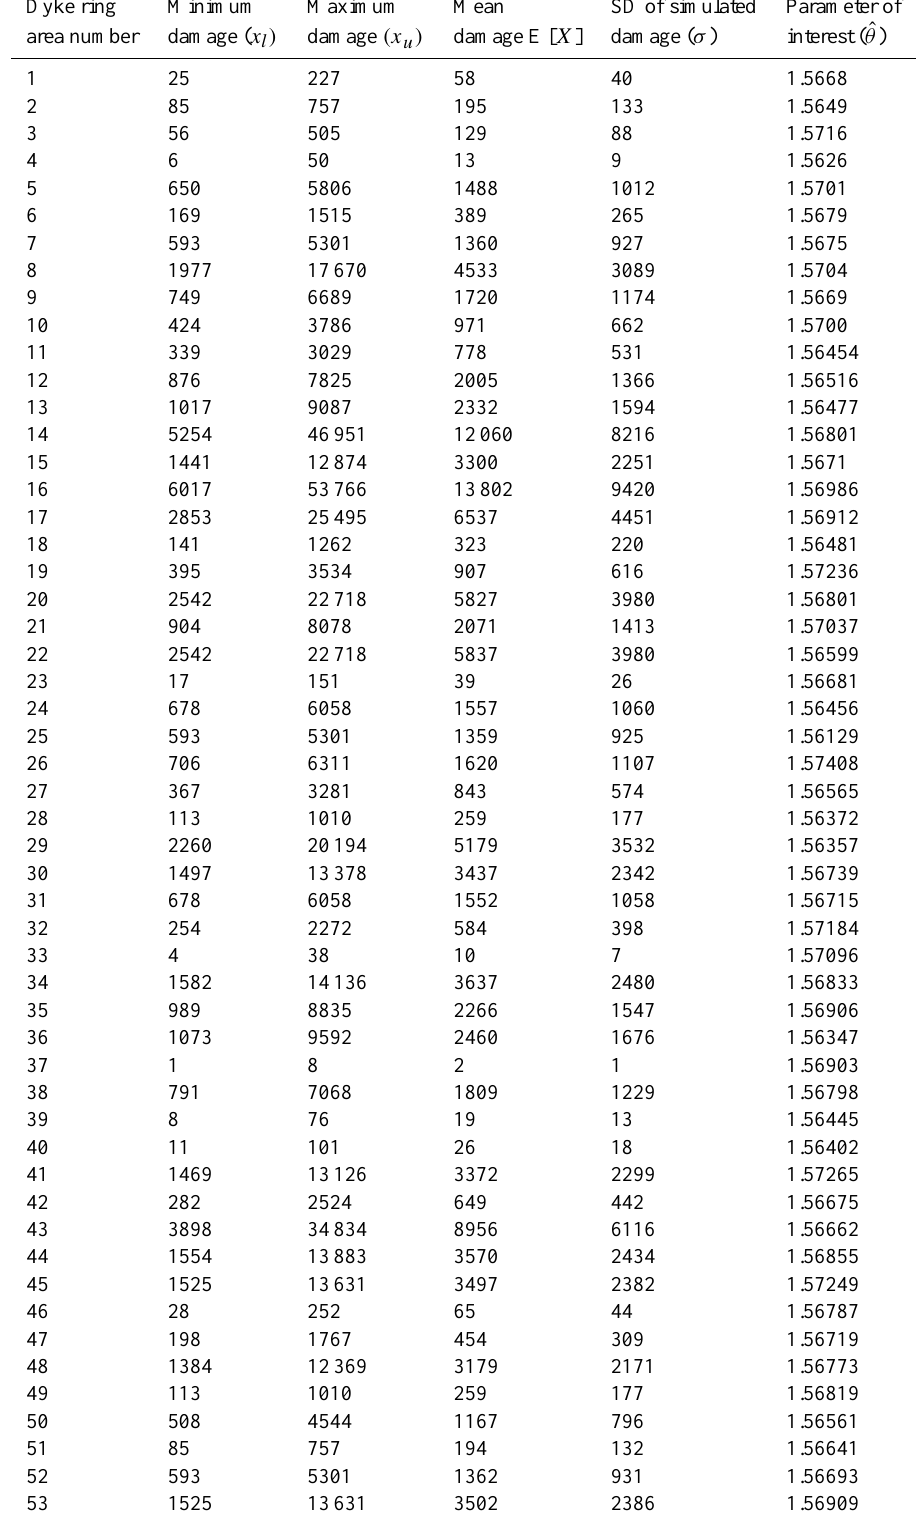
Table 2. Main flood risk statistics for all 53dyke ring areas (in million euros). Dyke